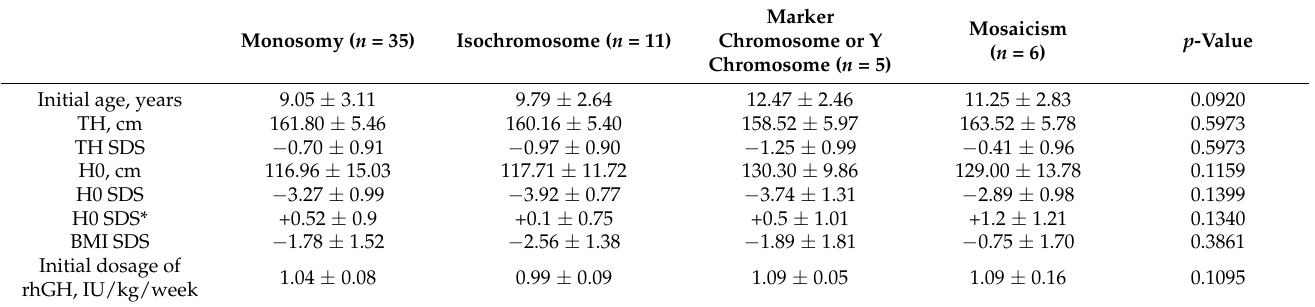
Table 2. Baseline clinical characteristics of TS patients undergoing rhGH therapy.